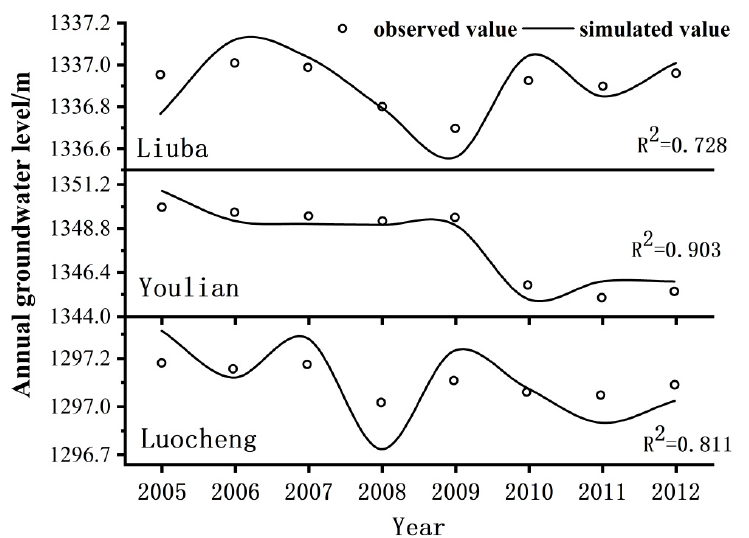
Figure 8. Simulation of the groundwater level in the middle reaches of the Heihe River from Pingchuan to Zhengyi Gorge.